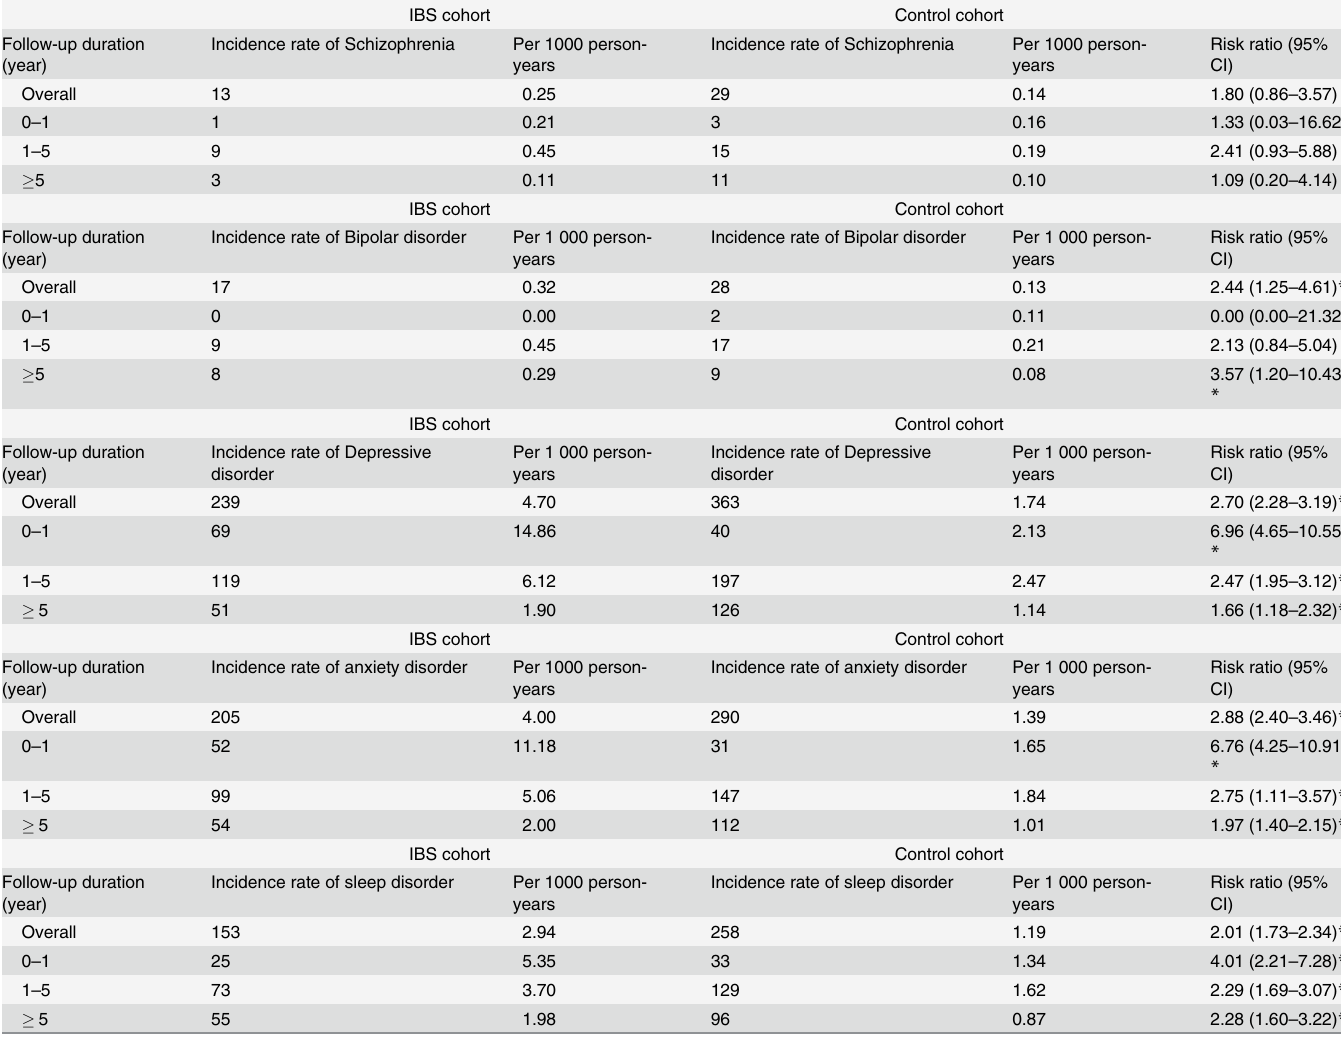
Table 2. The incidence rates of cases of newly diagnosed schizophrenia, bipolar, depressive, anxiety and sleep disorders between patients in the IBS and control cohorts, stratified by the follow-up duration. IBS cohort Control cohort